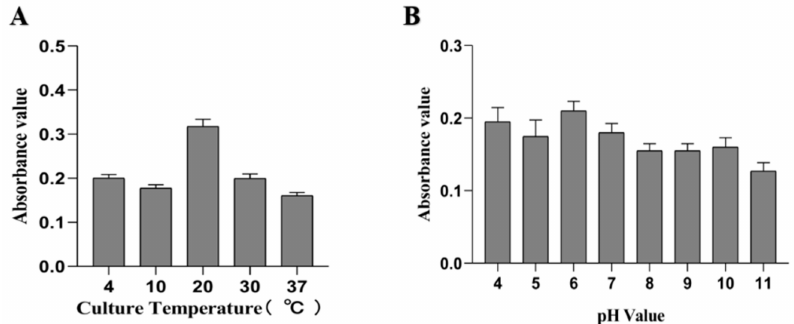
Figure 2. Di ff erential culture temperature ( A ) and pH ( B ) for A. veronii biofilm formation.